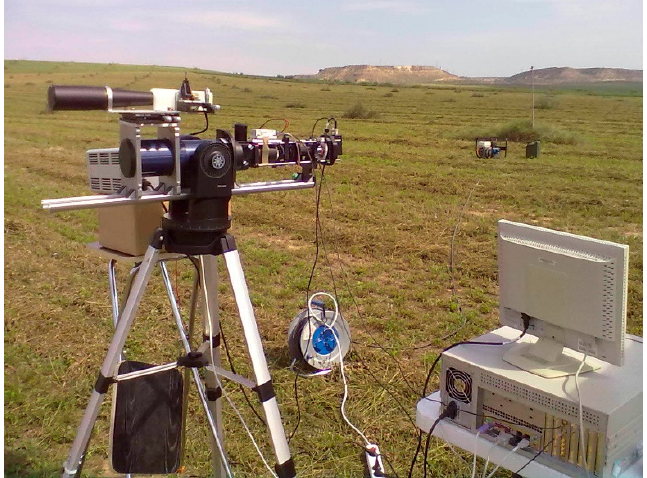
Figure 1. Picture of the developed lidar system deployed in the field.